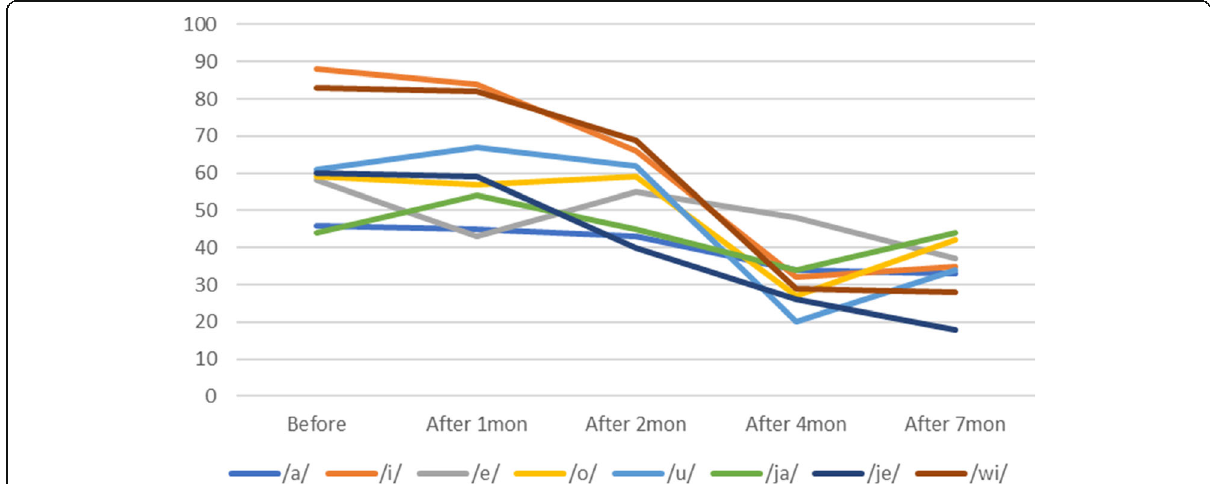
Fig. 4 Evaluation of hypernasality (vowels). Measurements of nasal emission energy in vowels using nasometer. After initiation of speech aid therapy, the nasality decreases with time